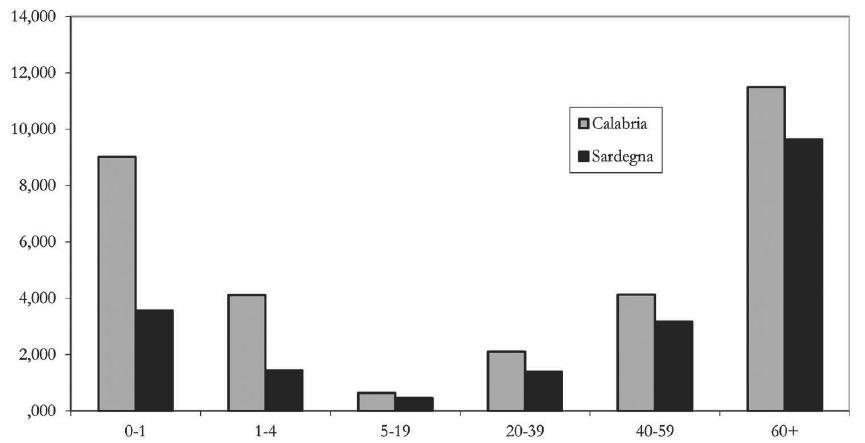
Figure 3b – Pneumonia age specific mortality rates (both sexes) in Calabria and Sardegna,